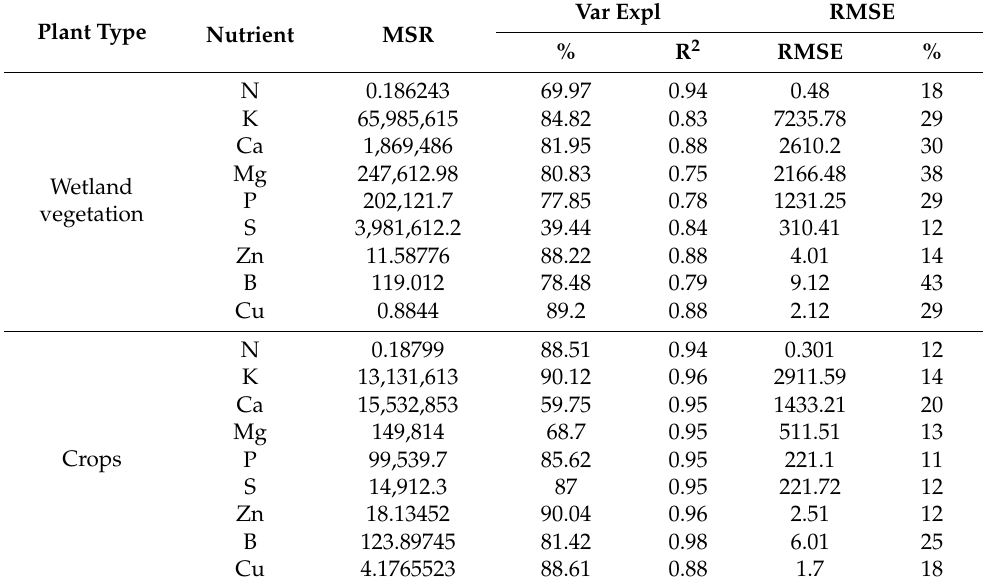
Table 7. Seasonal nutrient estimation accuracies for crops and vegetation.